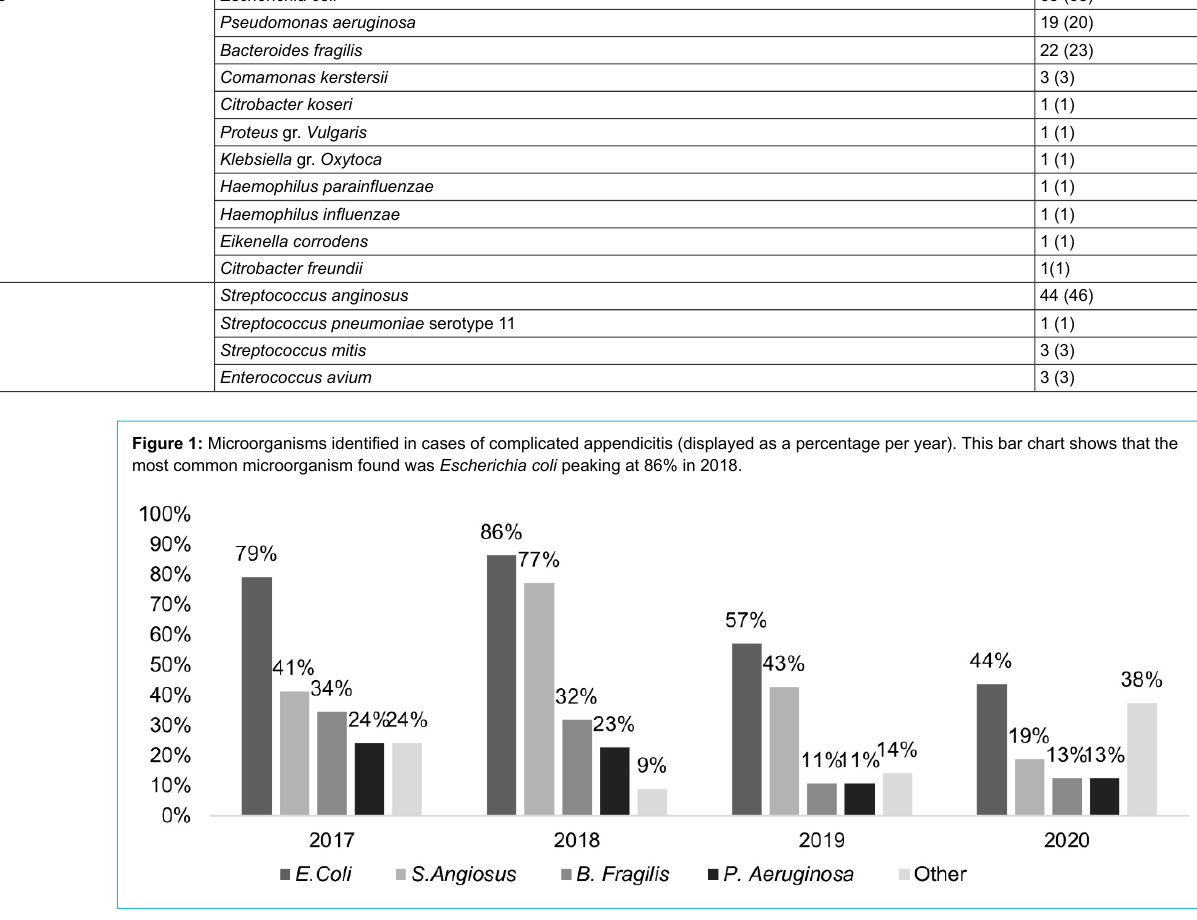
Table 3: Summary of antibiotics administered throughout this study at all possible stages (induction, postoperatively, discharge) for all years combined (2017–2020, n = 94). Antibiotic of choice Induction